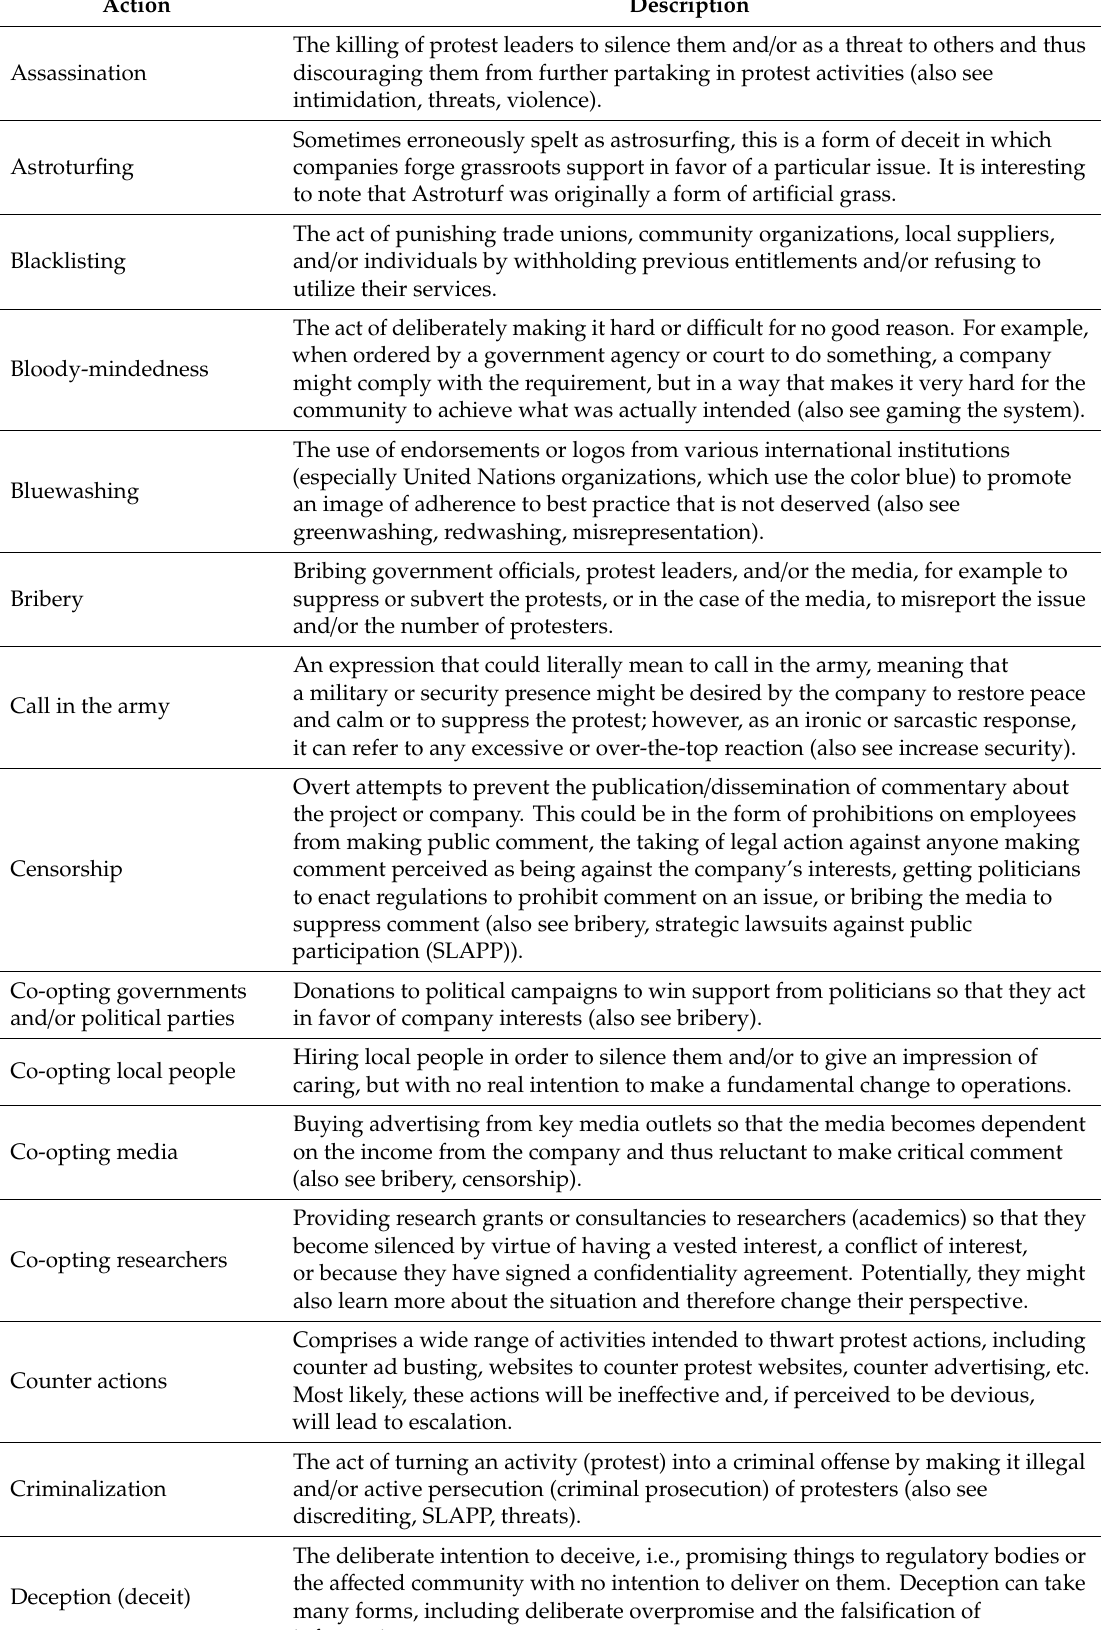
Table 2. Company actions likely to lead to escalation of